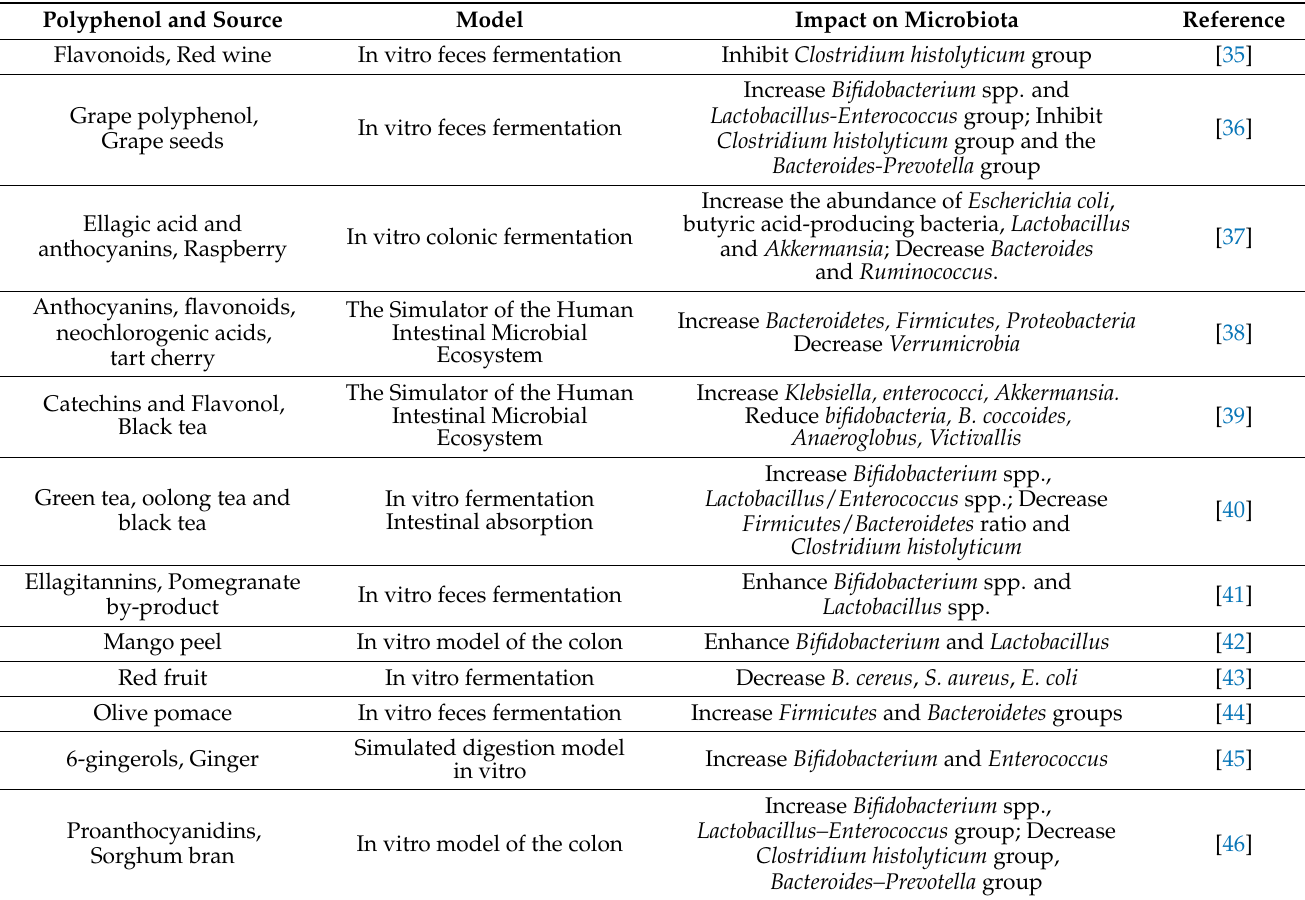
Table 1. Study on the effect of polyphenols on gut microbiota in